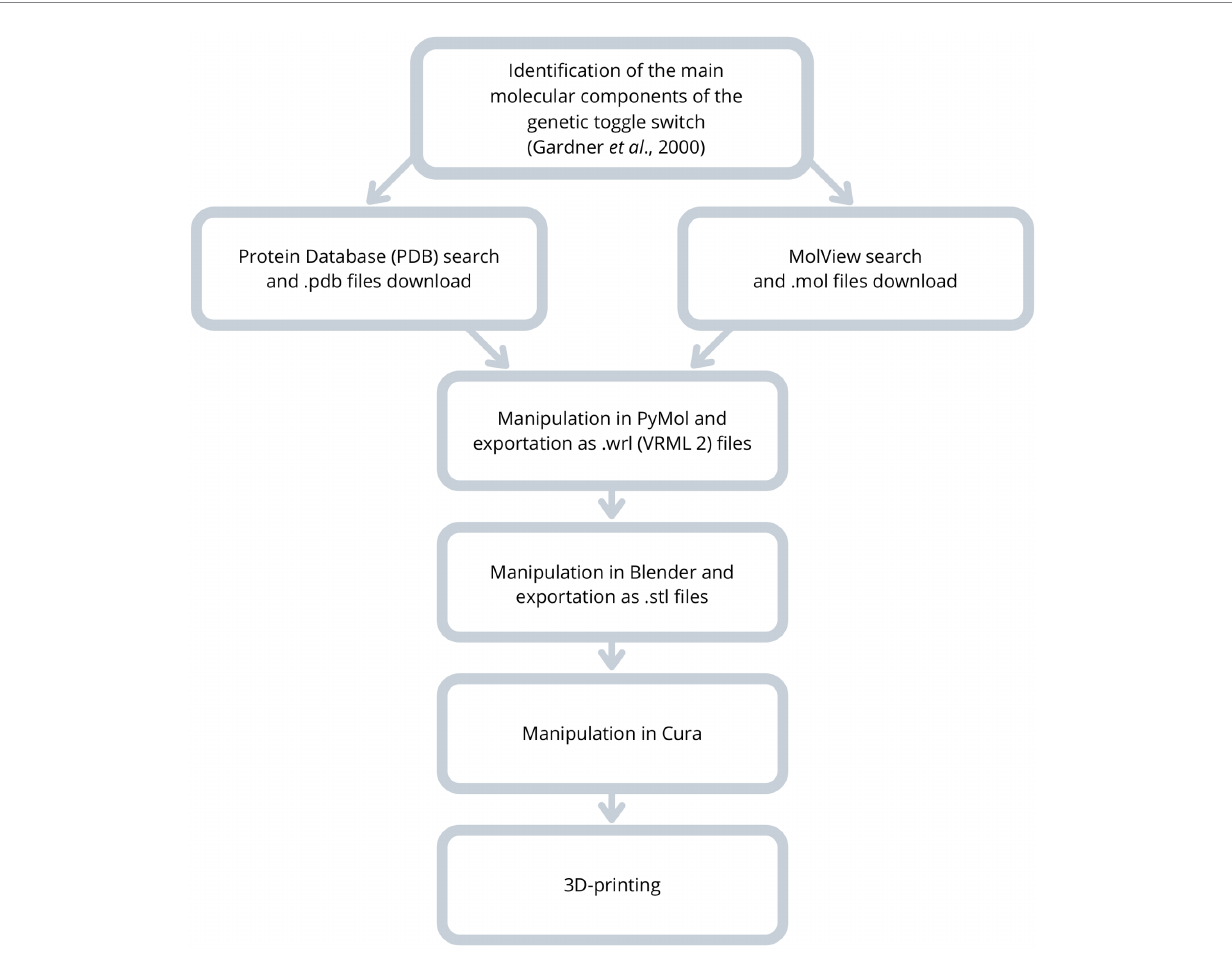
FIGURE 1 Schematic representation of the pipeline used for production of the genetic toggle switch as a system of 3D printed